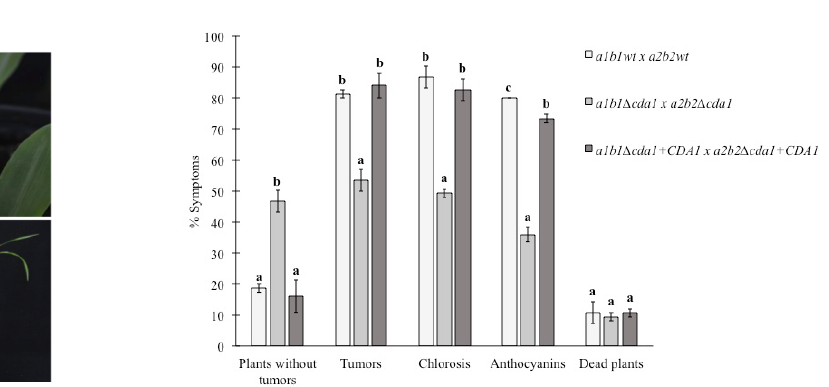
Figure 4. Virulence of Δ cda1 mutant strain. ( A ) Macroscopic symptoms of plants. ( a ) Morphology of tumors induced in corn plants by the mixture of wild type strains a1b1 × a2b2 . ( b , c ) Disease symp- toms induced by inoculation of the sexually compatible mixtures: a1b1wt × a2b2 Δ cda1 ; ( d ) a1b1 Δ cda1 × a2b2wt; and ( e , f ) Δ cda1 mutants a1b1 × a2b2 . ( B ) For each strain combination, three independent infection experiments were performed in the total of 75 infected plants. Symptoms were scored 14 days after infection (see Methods for details). The color code for disease rating is given at the bot- tom. Numbers at the right of the bars indicate the average percentage in each disease category.